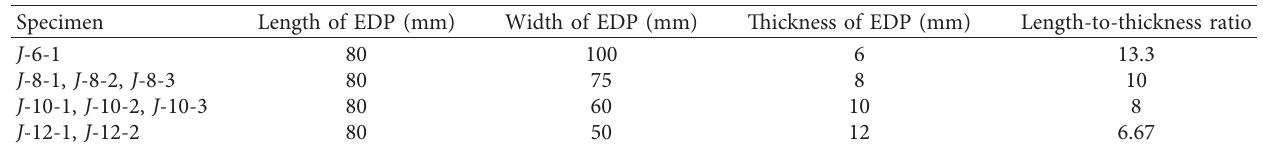
Figure 1: Energy-dissipation joint for hybrid frames: (a) schematic picture; (b) details of EDP; (c) details of the connection. Table 1: Parameters of the tests.